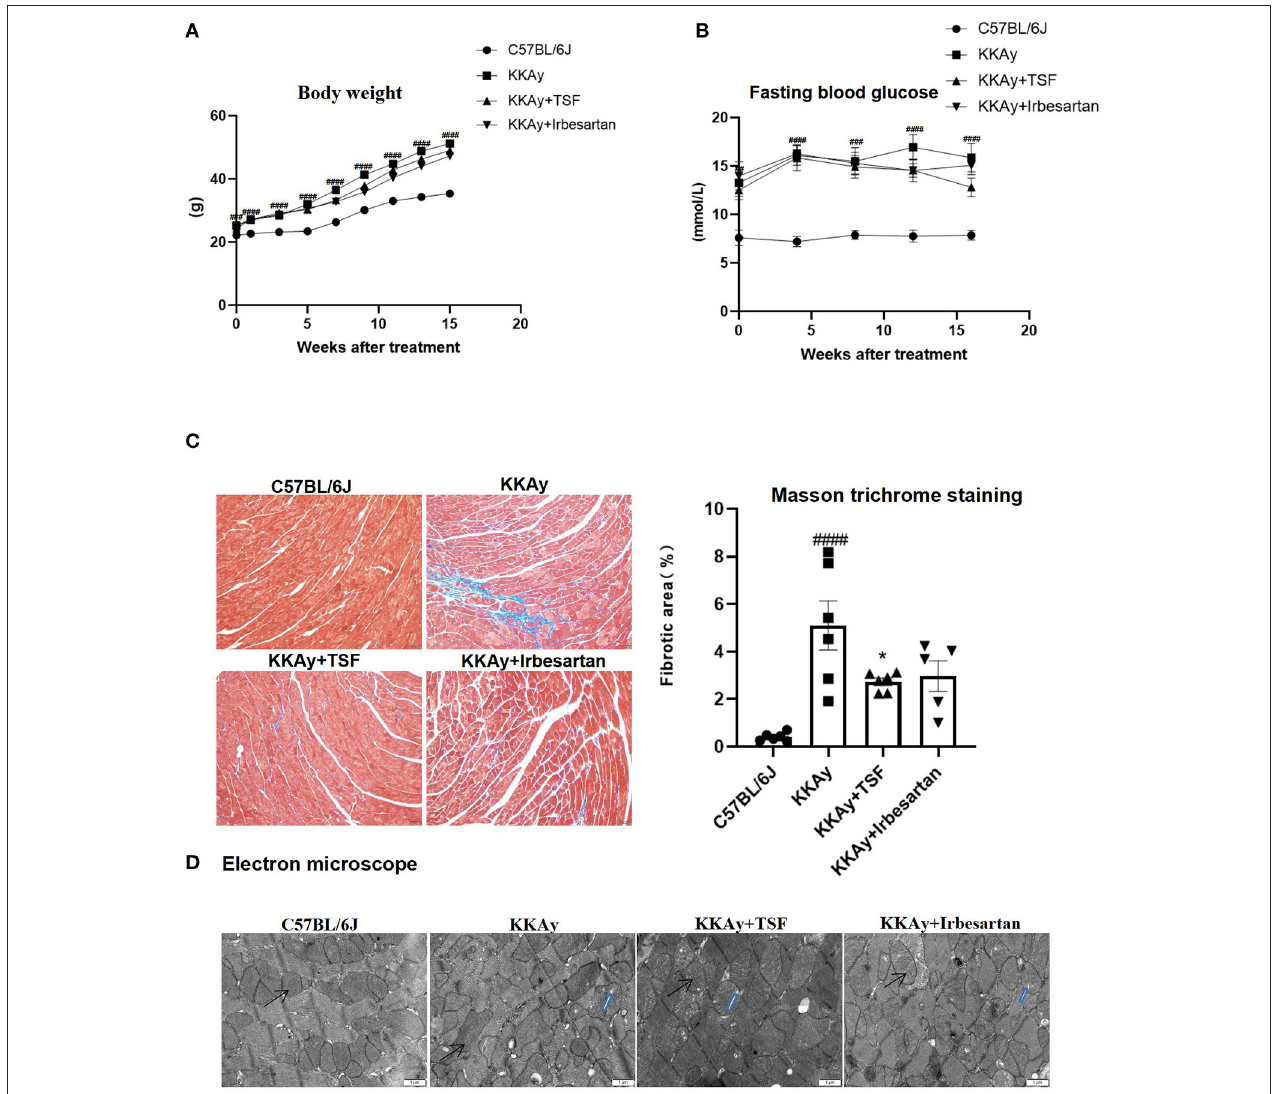
FIGURE 1 | Pathologic changes after Tangshen Formula (TSF) and irbesartan treatments. (A) Body weights were recorded once a week. Data are expressed as mean ± SEM. ### p < 0.001, #### p < 0.0001 KKAy group vs. C57BL/6J group. (B) Fasting blood glucose. After 16 weeks, glucose levels in KKAy mice were significantly increased. TSF-treated KKAy mice exhibited no statistical differences in glucose levels. Data are expressed as mean ± SEM. ### p < 0.001, #### p < 0.0001 KKAy group vs. C57BL/6J group. (C) Histology (Masson trichrome staining, original magnification, 200 × ) and semiquantification of the collagen area. Data are expressed as mean ± SEM. n = 6. * p < 0.05 TSF-treated group vs. KKAy group; ### p < 0.001 #### p < 0.0001 KKAy group vs. C57BL/6J group. (D) Ultrastructural findings of myocardial tissues in four groups of mice. Magnification × 12,000. Scale bar = 1 µ m. Black arrows indicate mitochondria. Blue arrows indicate mitochondria